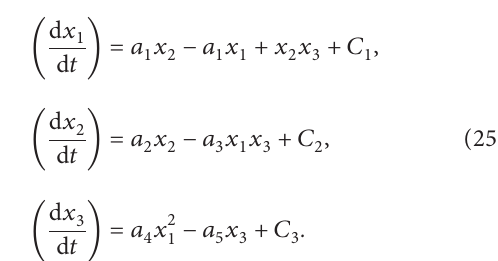
( t ) ,x ( t )) plan, a 1 3 � 1